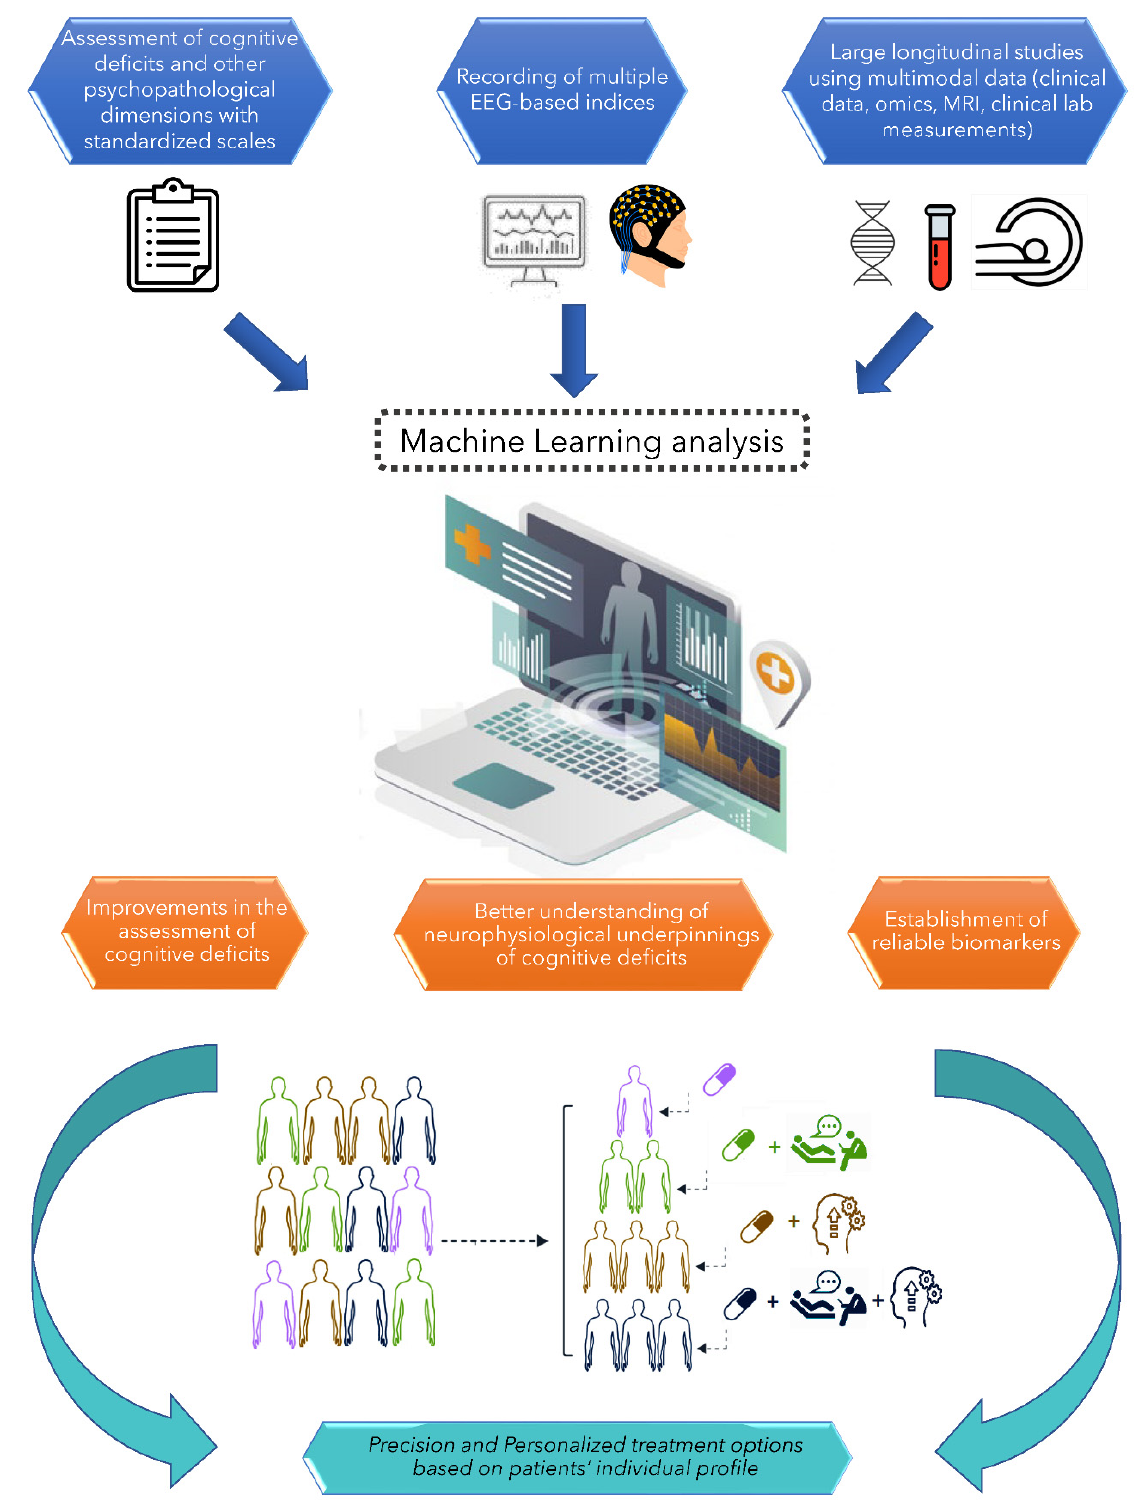
Figure 2. Future directions for the implementation of EEG-based measures in clinical settings. Large studies based on in depth characterization of the studied population, standardized methods, and adopting state of the art tools and indices, together with the implementation of machine learning approaches, might contribute to increase the use of EEG-based measures in clinical